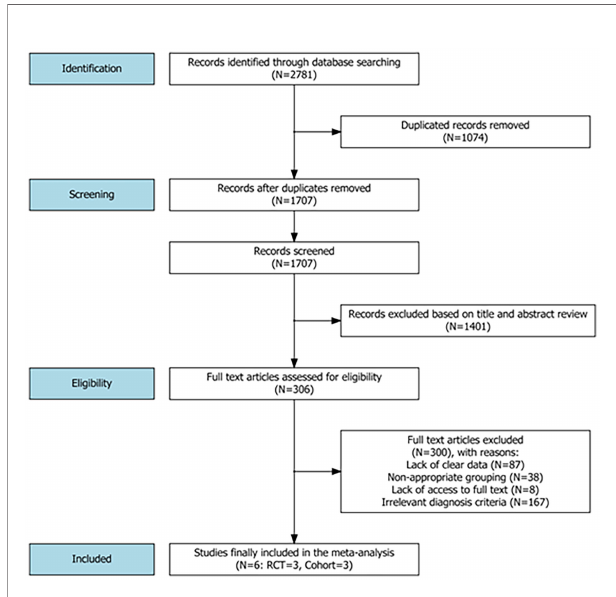
FIGURE 1 | A fl owchart of the literature search strategy and study